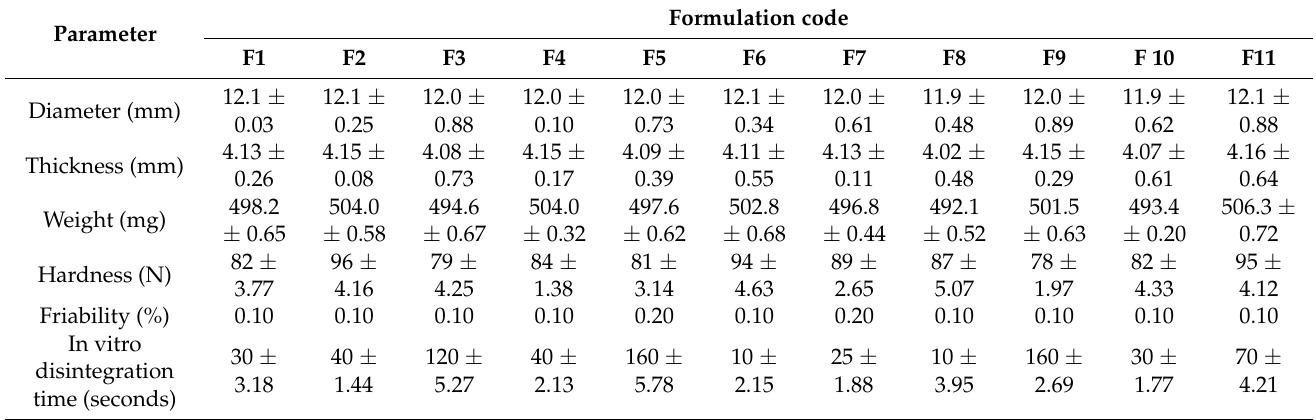
Table 6. AMH SD oral immediate-release tablets